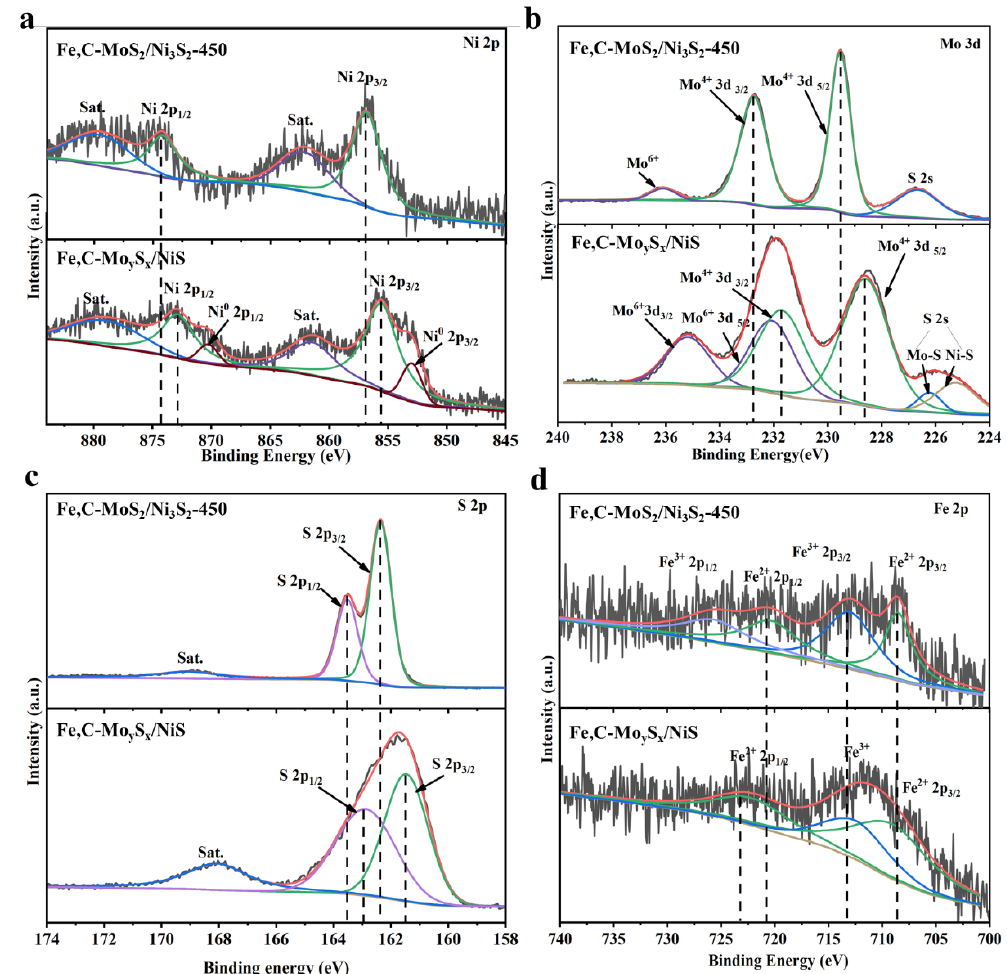
Figure 3. XPS spectra of Fe, C-MoS 2 /Ni 3 S 2 -450 and Fe, C-Mo y S x /NiS: high-resolution XPS analysis of ( a ) Ni 2p, ( b ) Mo 3d, ( c ) S 2p, ( d ) Fe 2p spectra.